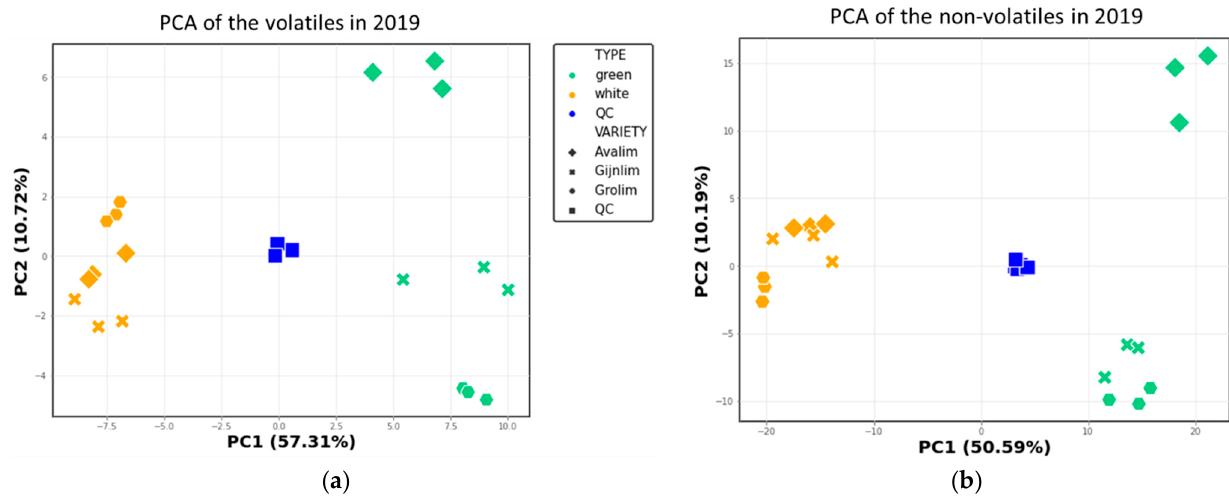
Figure 3. PCA score plots based on ( a ) 84 volatiles and ( b ) 442 non-volatiles detected in the green and white asparagus spears harvested in 2019: the first two PCs are presented, and the explained variance is shown in parentheses on the axes. Colours indicate the asparagus type; symbol shapes indicate asparagus variety.